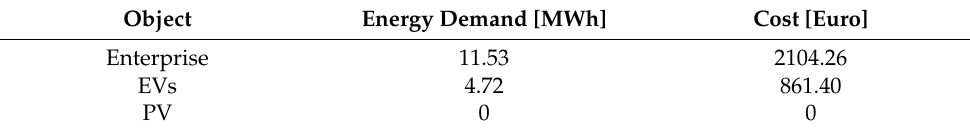
Table 3. Summary of energy consumption for the company and the vehicle fleet for model